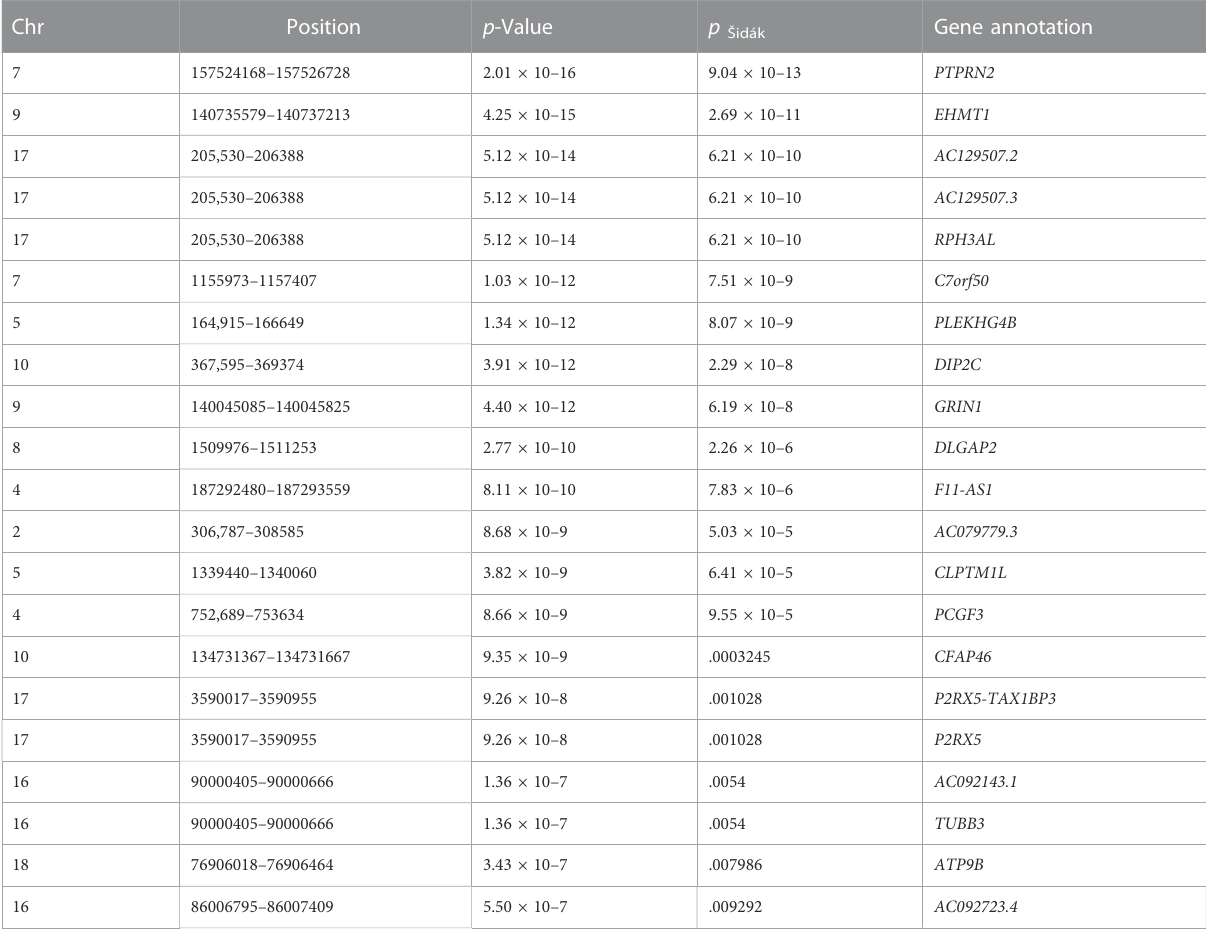
TABLE 2 Differentially methylated regions associated with antipsychotic